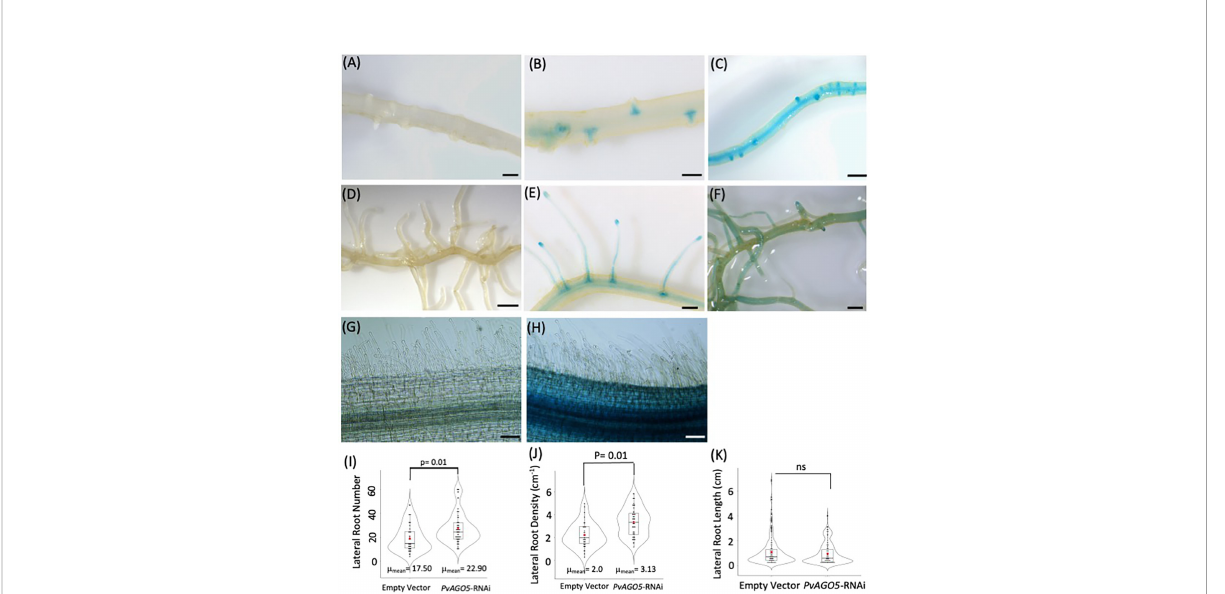
FIGURE 1 PvAGO5 is expressed in lateral roots under nonsymbiotic condition. P. vulgaris composite plants with transgenic roots expressing either the empty vector (A, D, G) or the pPvAGO5:GUS-GFP construct (B, C, E, F, H) were grown under optimal-nitrogen conditions for three weeks. Roots expressing the pPvAGO5:GUS-GFP displayed GUS signal in the lateral roots primordium and mature lateral roots (B, C, E, F) . Scale bars represent 500 m m. Images shown are representative of ten biological replicates, each one containing ten transgenic roots. Transgenic roots expressing the empty vector or pPvAGO5:GUS-GFP construct shown no GUS activity at the root hairs (G, H) . (I) Number and density (J) of lateral roots formed in transgenic roots expressing the empty vector or the PvAGO5 -RNAi construct. (K) Lateral root length of PvAGO5 -RNAi transgenic roots compared with the empty vector transgenic roots. Boxes indicate the second and third quartiles, with median and mean values indicated as a line and red dot, respectively. Data shown was obtained from ten biological replicates, each one containing ten transgenic roots. Statistical signi fi cance was obtained using Welch ’ s t -test. ns, not signi fi